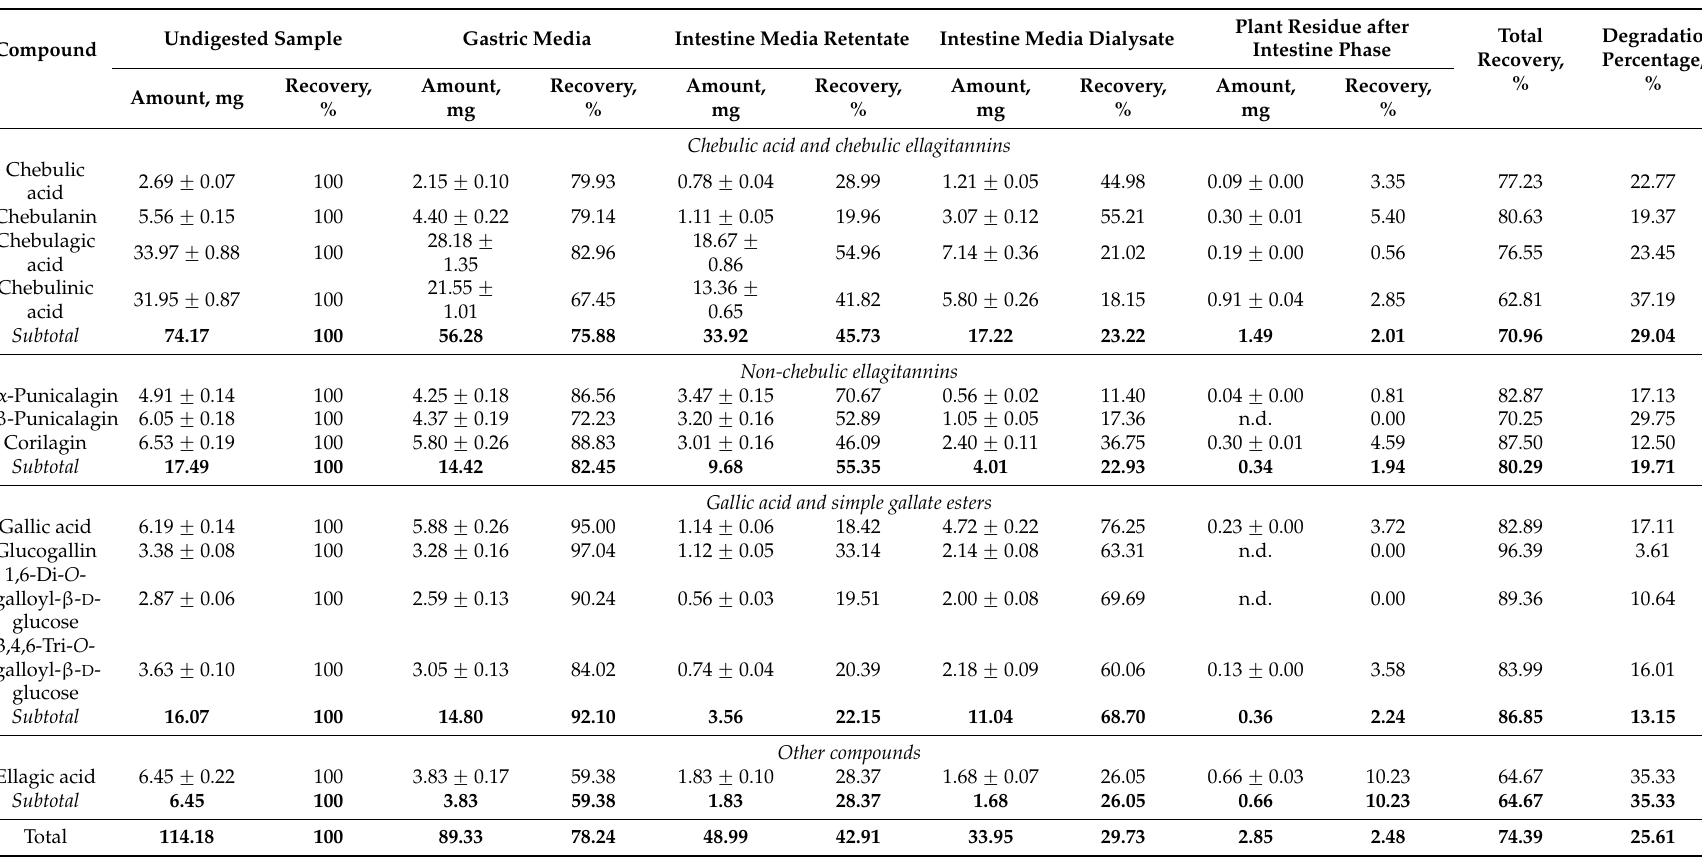
Table 2. Amount and recovery of phenolic compounds in undigested sample, gastric, and intestine media and plant residue obtained following in vitro gastrointestinal digestion of Padma